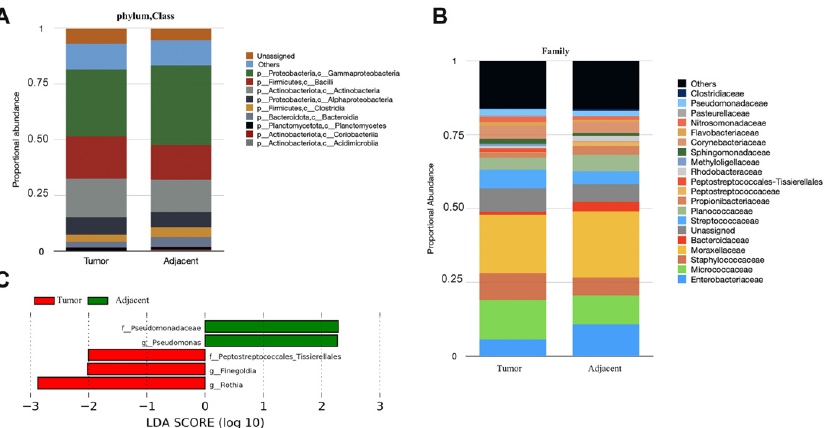
Figure 1. Breast microbiota is distinct between tumor and adjacent breast tissues. ( A ) Taxonomic profiles of adjacent ( n = 47) and tumor pair ( n = 47), microbiota at class level, and ( B ) family level for taxa with a difference in relative abundance between tumor and adjacent tissues >0.038 are shown.